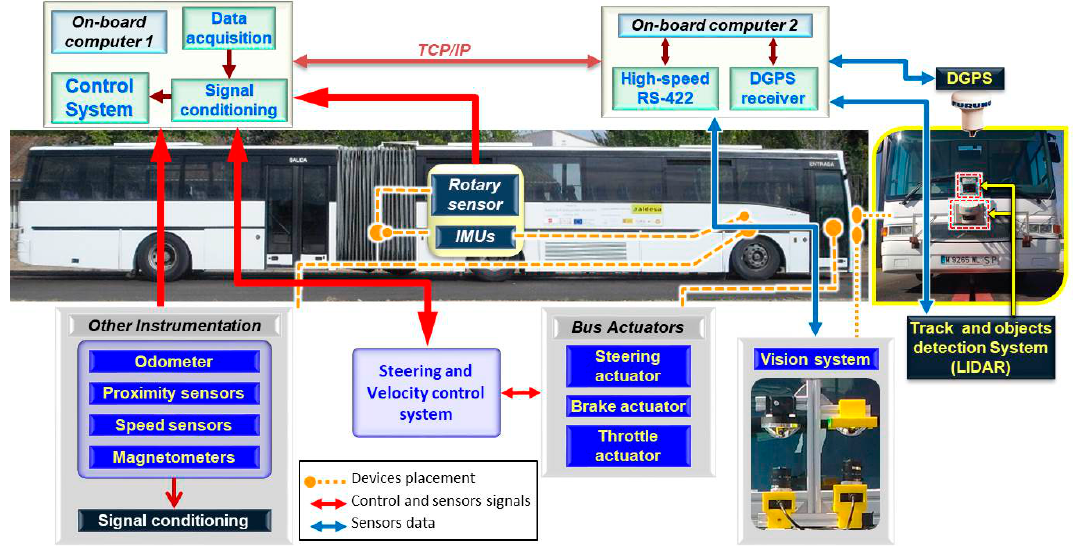
Figure 11. The architecture of the experimental platform. Appl. Sci. 2017 , 7 , 1131